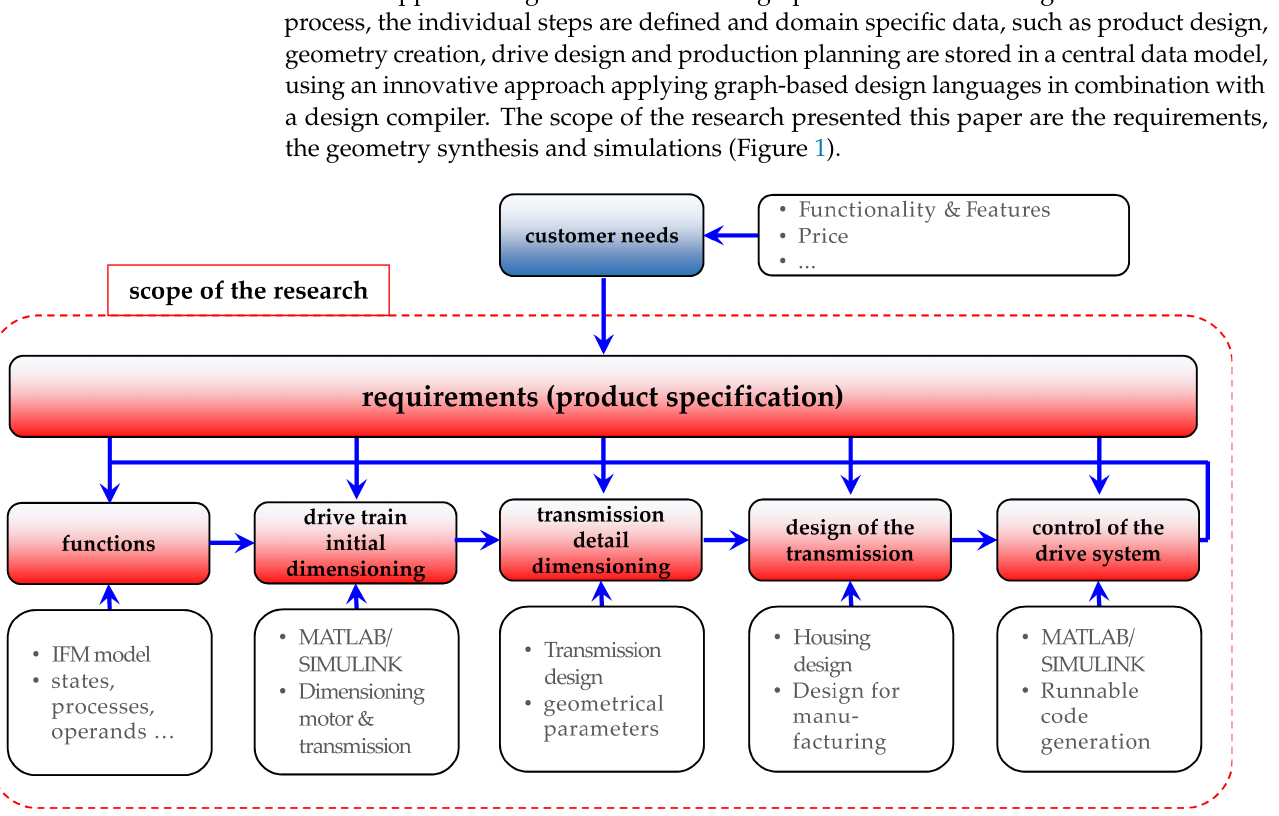
Figure 1. Scope of the presented